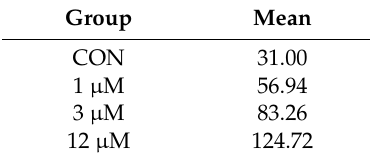
Table 7. Compound 4 effect on the cellular calcium of